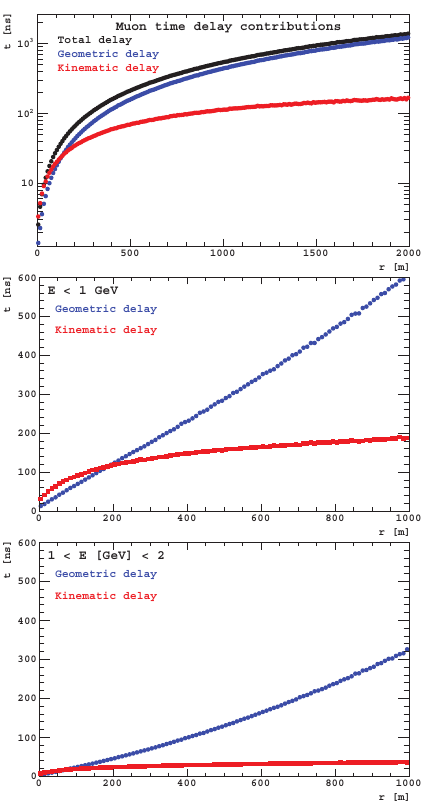
Figure 6. Top panel: Correlation matrix between the predicted and Monte Carlo MPD. Bottom panel: Example of one recon- structed apparent MPD profile using DNNs (red histogram). For comparison, the Monte Carlo profile is also plotted in the figure as the black